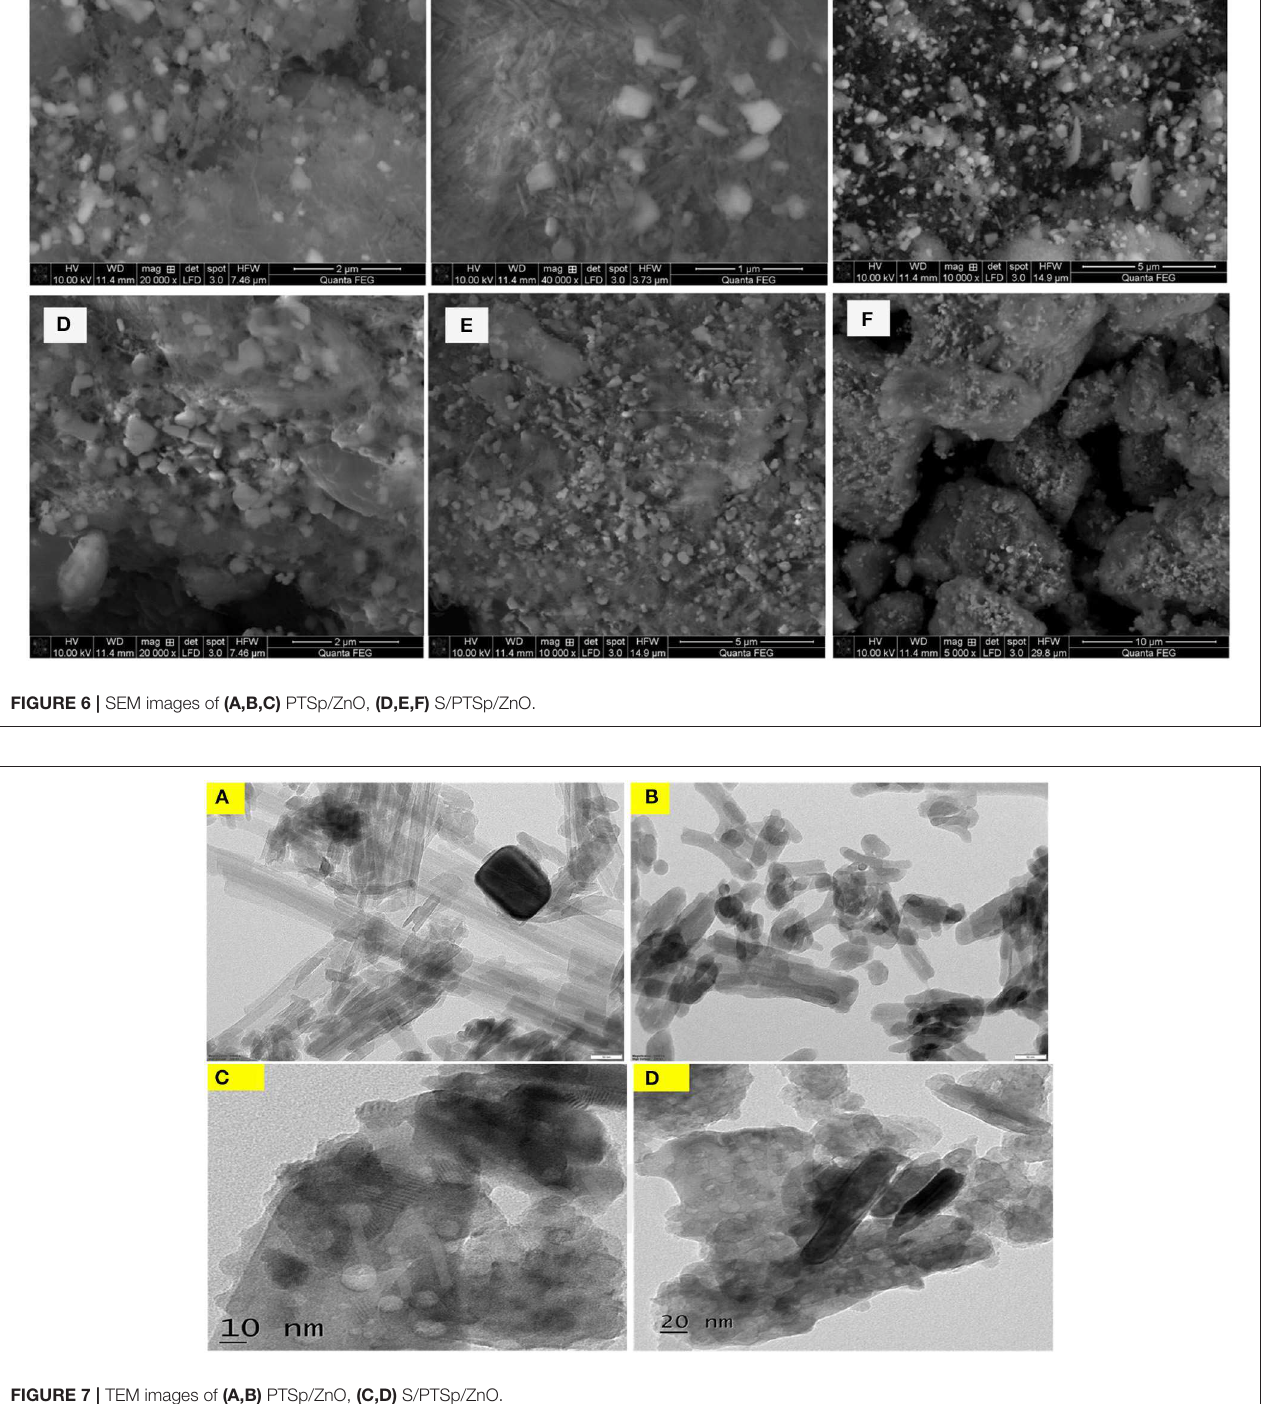
C-H asymmetric stretching vibration. 1,636 cm − 1 are entrusted to the C = O extending vibration. The Si-O and O-H groups can be clearly observed in the FTIR of